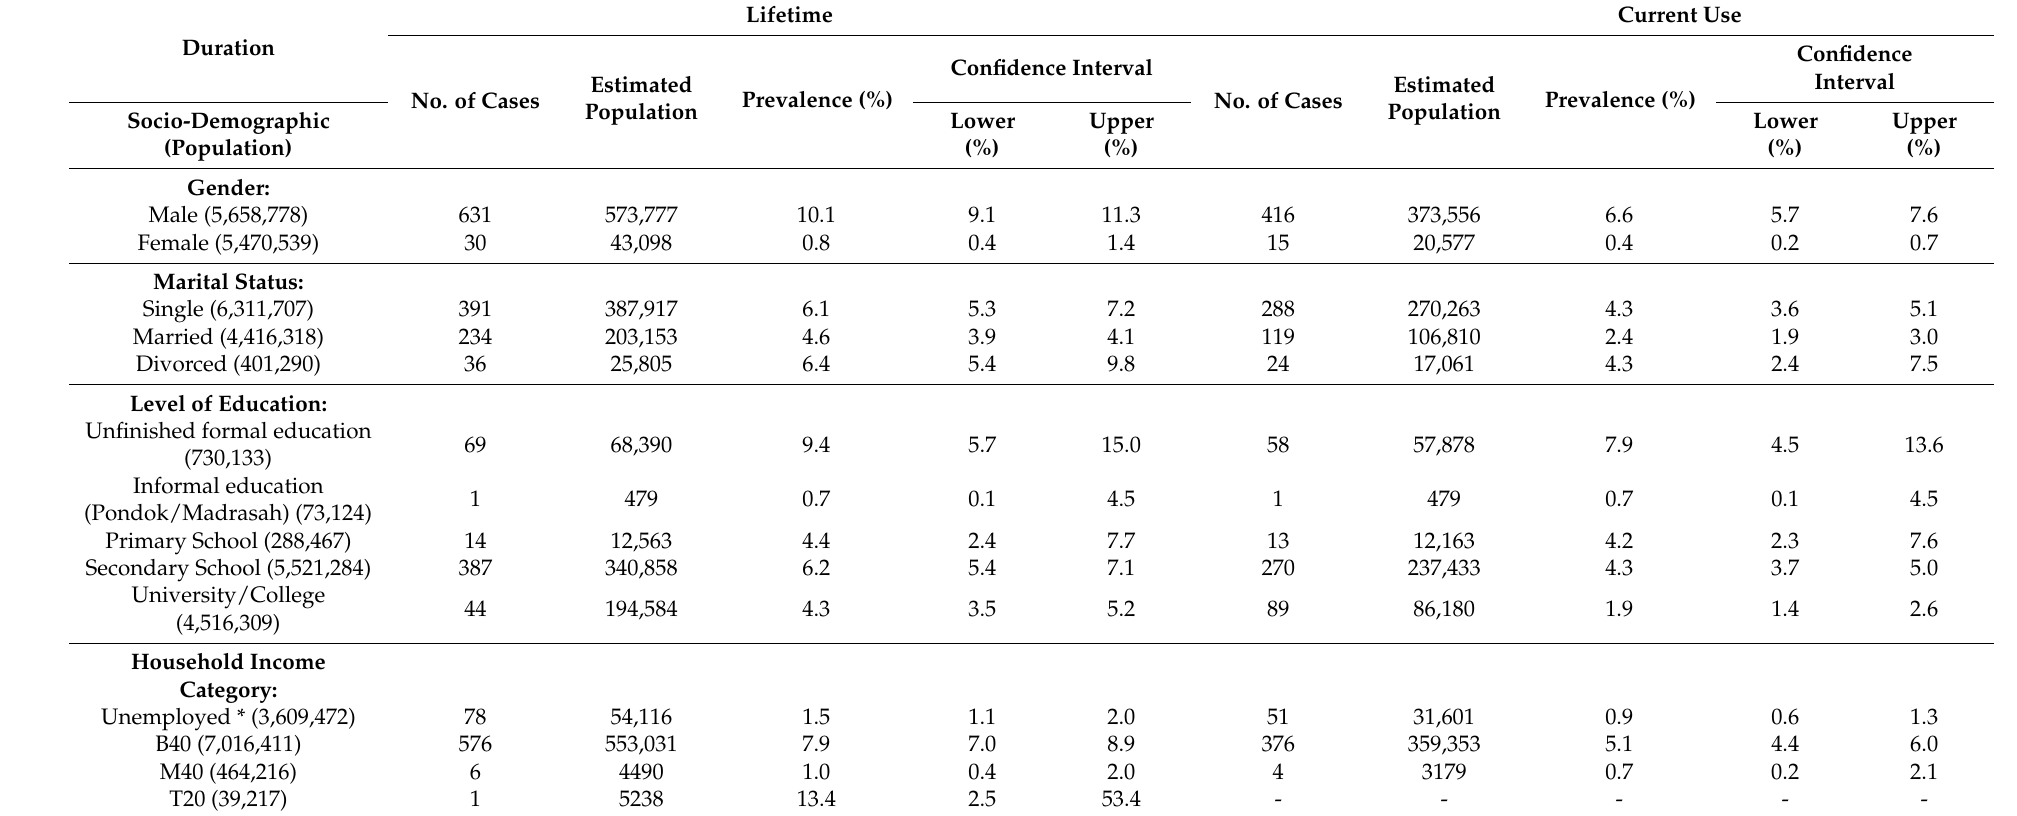
Table 7. Prevalence rate of drug use according to socio-demographic characteristics ( n =